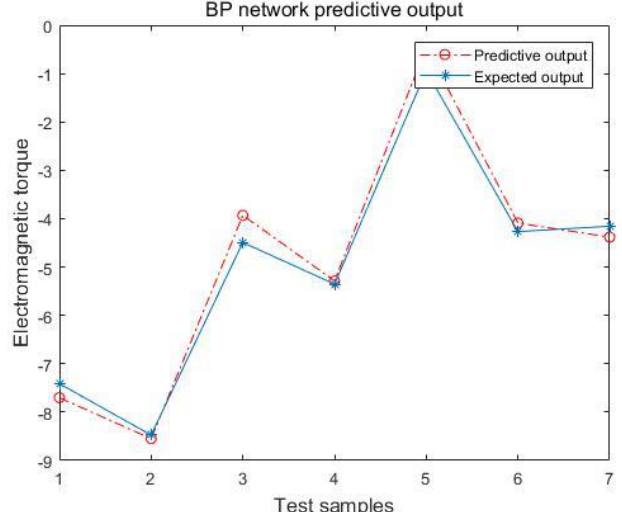
Figure 15. Backpropagation (BP) neural network prediction results.